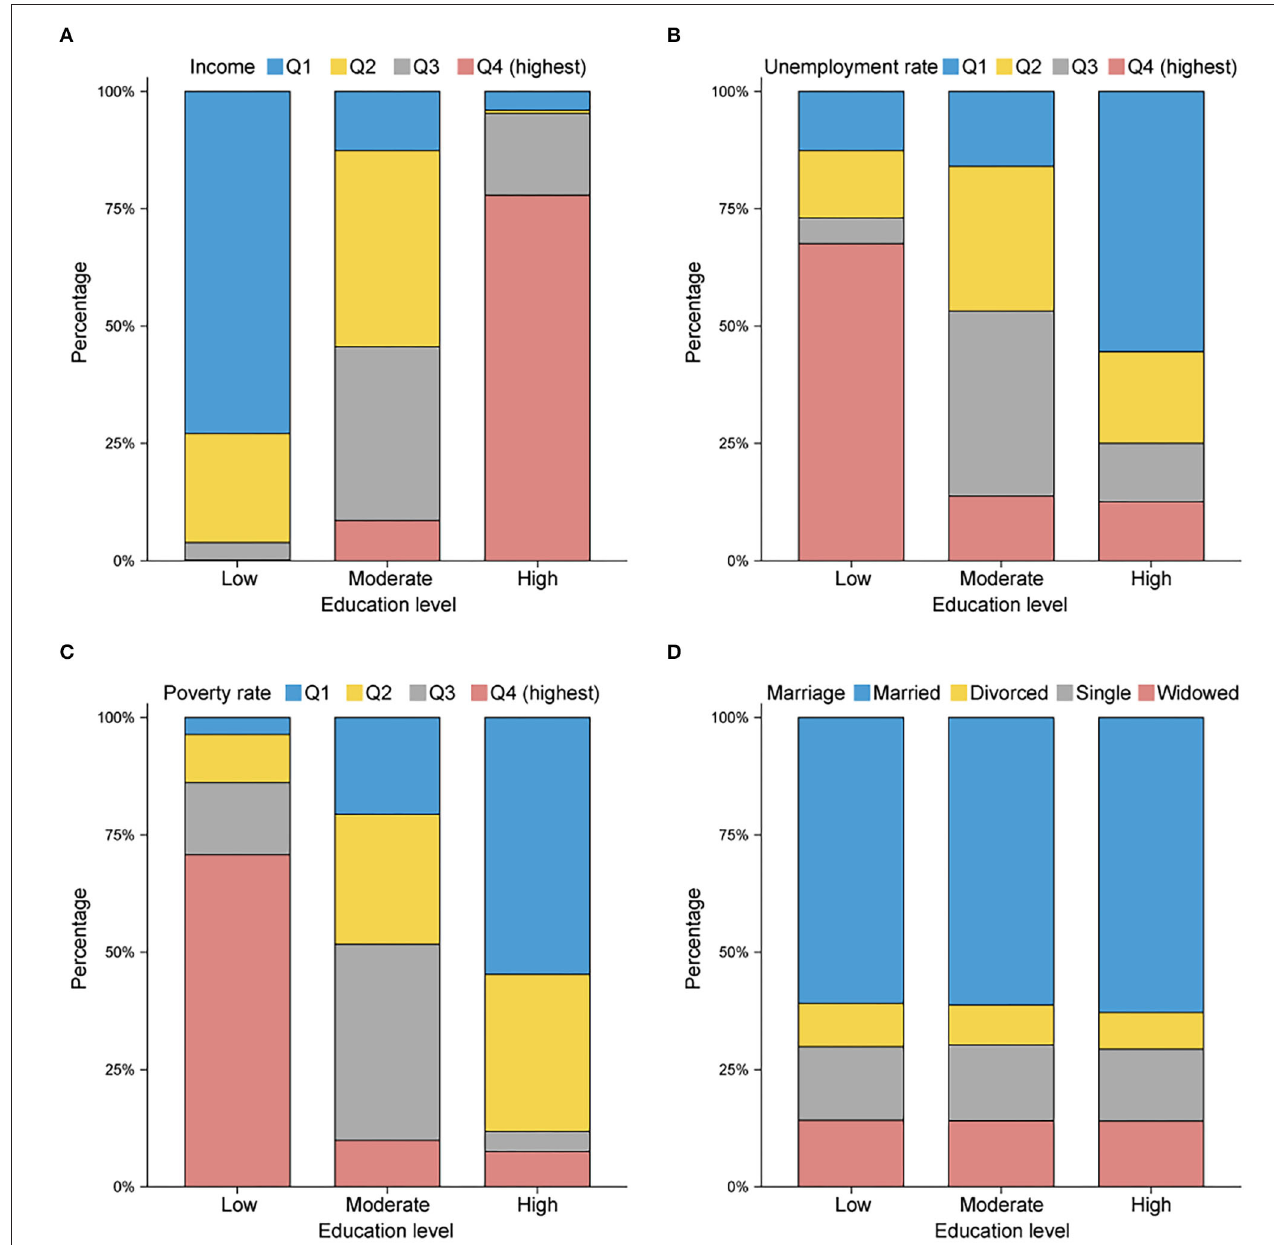
FIGURE 2 | Histogram plots reflecting the proportions in (A) median household income, (B) unemployment rate, (C) poverty rate, and (D) marital status, stratified by county education level. Q1, quartile 1 (lowest); Q2, quartile 2 (lower); Q3, quartile 3 (higher); Q4, quartile 4 (highest). Counties with higher education levels tend to have higher average income levels and lower unemployment and poverty